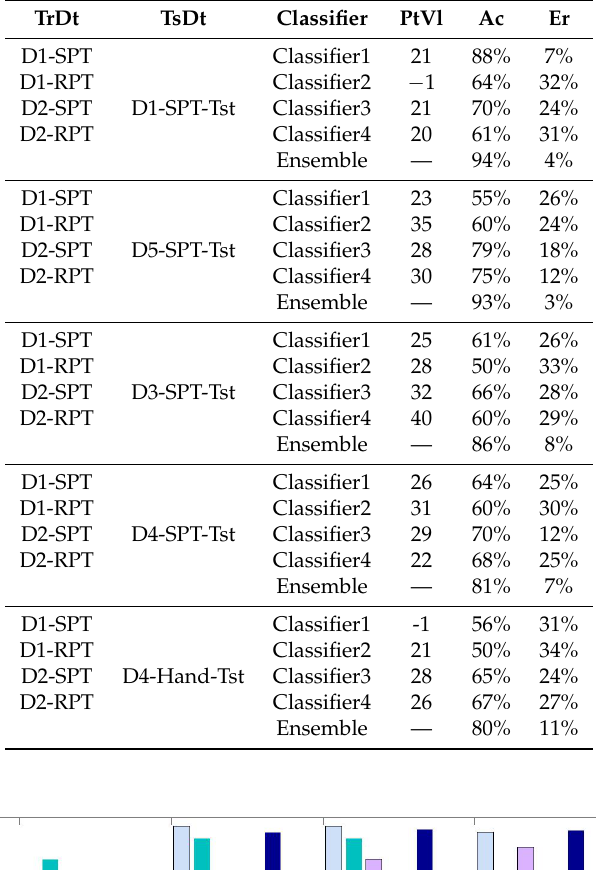
Table 6. Summary of classification accuracy (in %) obtained for different training and test devices with four condition-based classifiers and an ensemble of these classifiers. D1 and D2 are considered as training devices; D3, D4 and D5 are considered as test devices. Devices are kept at different positions (SPT, RPT, or Hand). The column headings are: Training Dataset (TrDt), Test Dataset (TsDt),